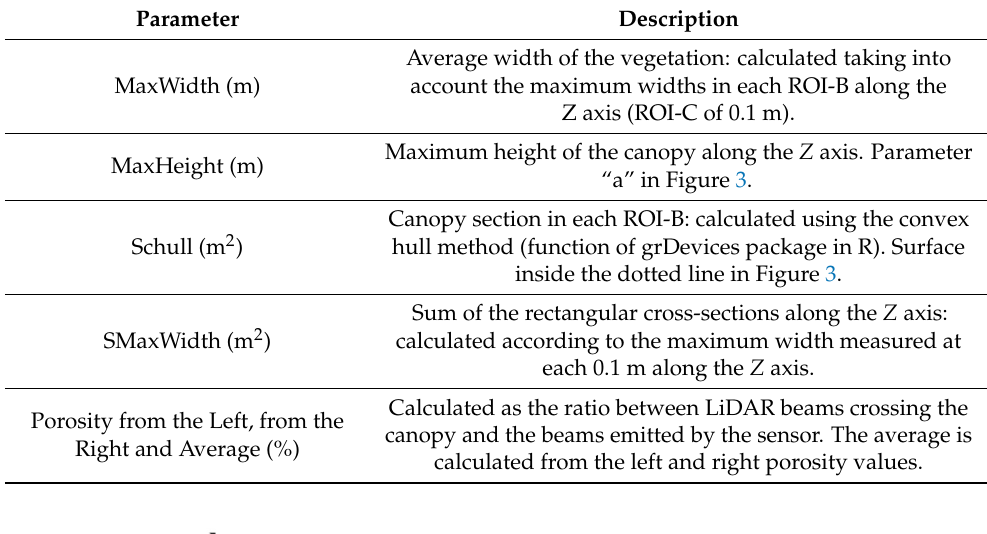
Table 1. Structural and geometric canopy parameters extracted from the LiDAR point cloud every 0.5 m along the tree rows. See representation in Figure 3.